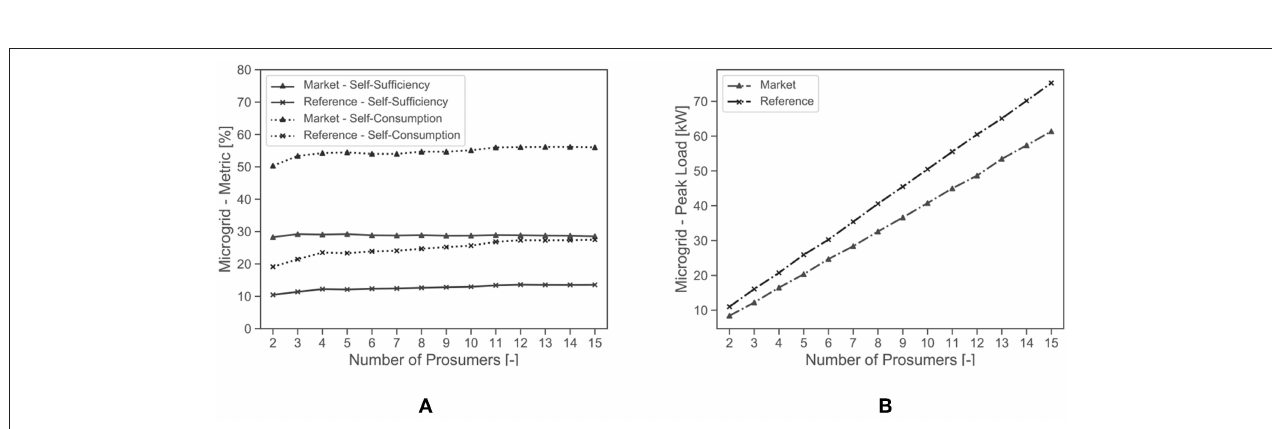
Frontiers in Energy Research |